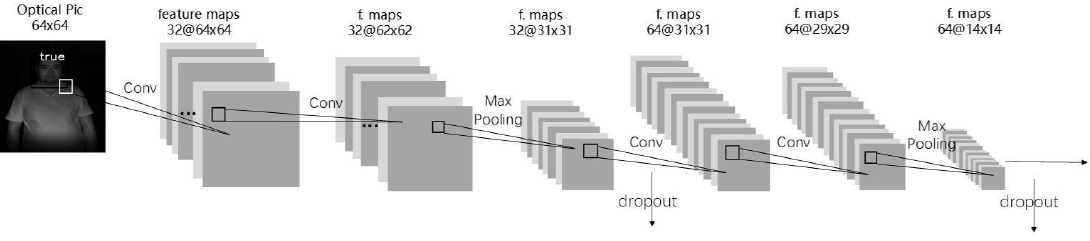
Figure 3. CNN structure. Figure 3. CNN